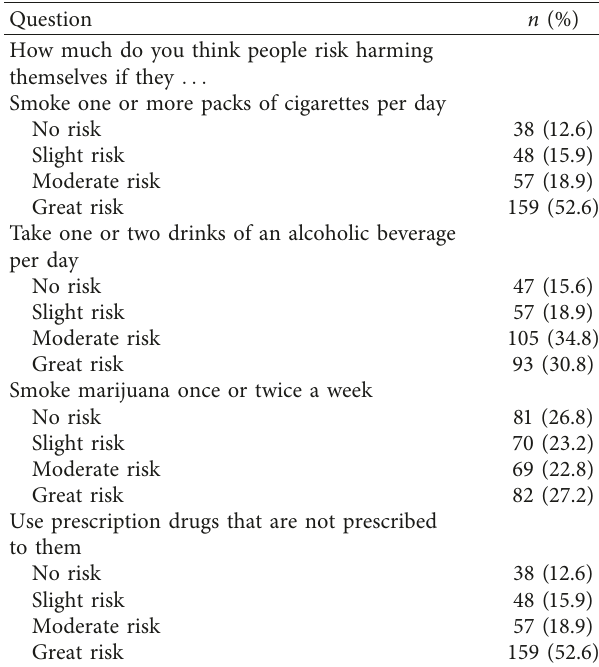
Table 5: Attitudes towards alcohol and substance